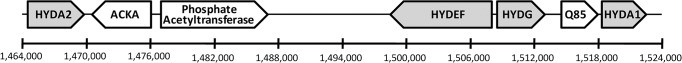
[FeFe]-hydrogenase operon-like gene cluster in V. carteri.Four genes with sequence similarity to HYDA1, HYDA2, HYDEF, and HYDG are arranged within 60 kb of one another. The gene orientation corresponds to the orientation of each shape. Three additional putative genes are within this region: ACKA (XP_002948613), a phosphate acetyltransferase (XP_002948484), and a predicted gene, Q85 (XP_002948486). These three predicted gene products are not hypothesized to catalyze H2 production or assist in the assembly of the [FeFe]-hydrogenase active site, and these genes are not found within investigated bacterial [FeFe]-hydrogenase gene clusters.